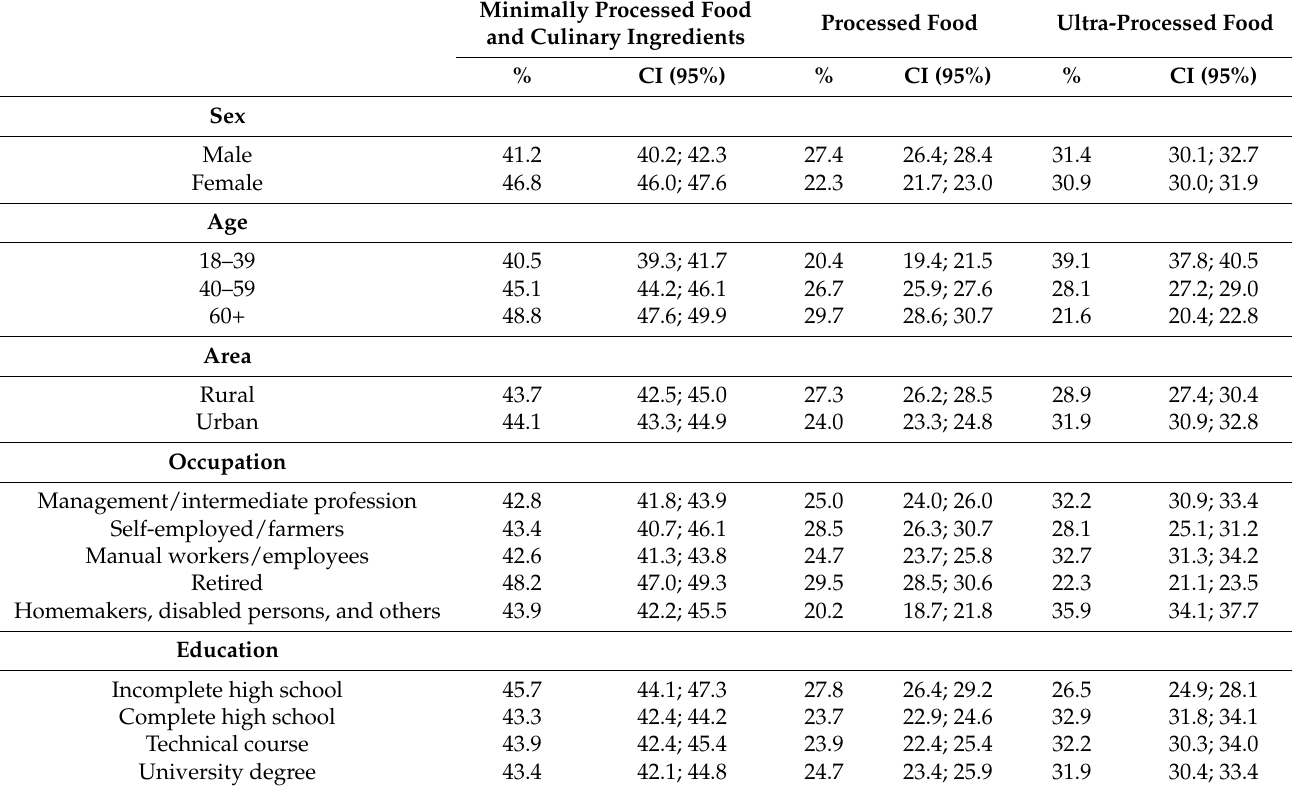
Table 3. Mean percentage of total energy intake from NOVA food groups according to sociodemographic characteristics. French population aged ≥ 18 years. ENNS 2006 ( n =